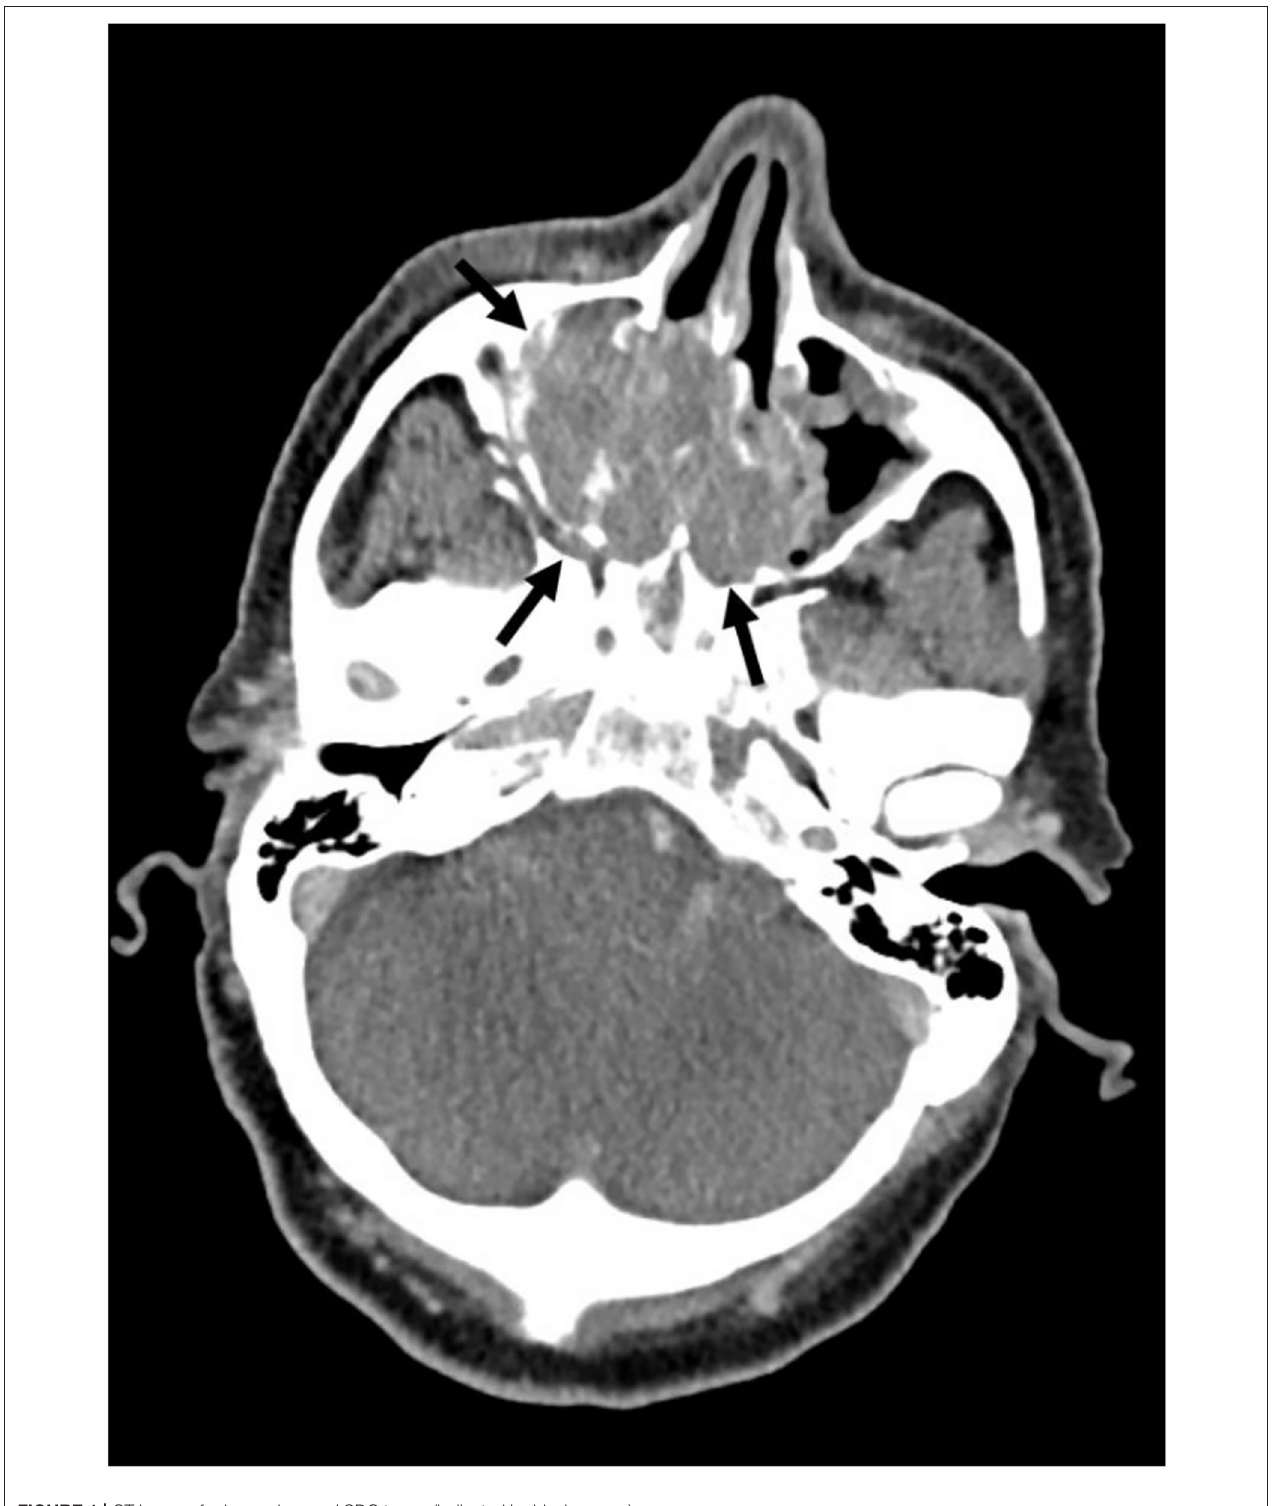
FIGURE 1 | CT image of primary sinonasal SDC tumor (indicated by black arrows).